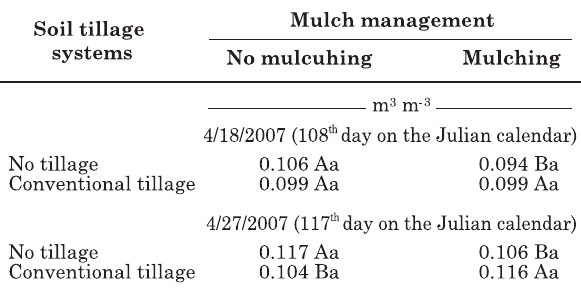
Table 2. Soil water content in the 0–20 cm layer for soil tillage systems and mulch management in 2007 (1)